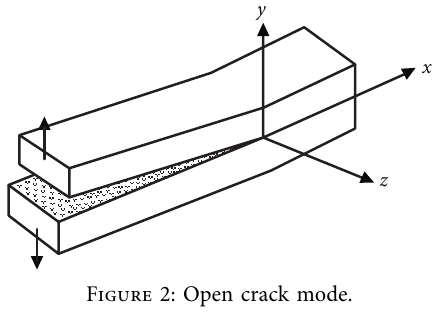
Figure 2: Open crack